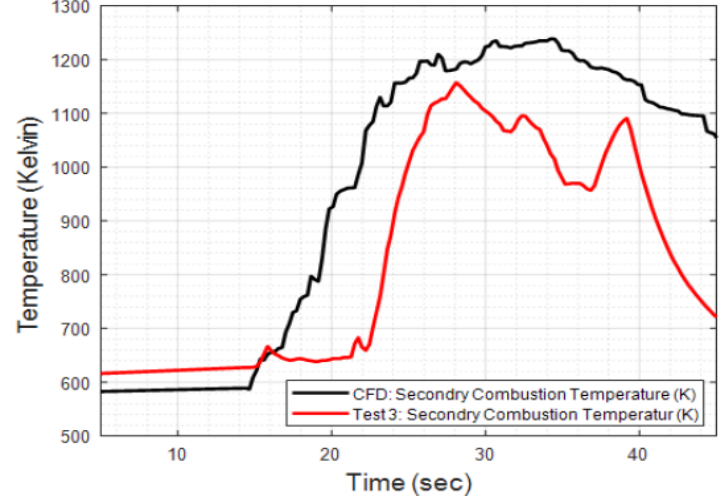
Figure 22. Comparison of secondary combustion temperature.